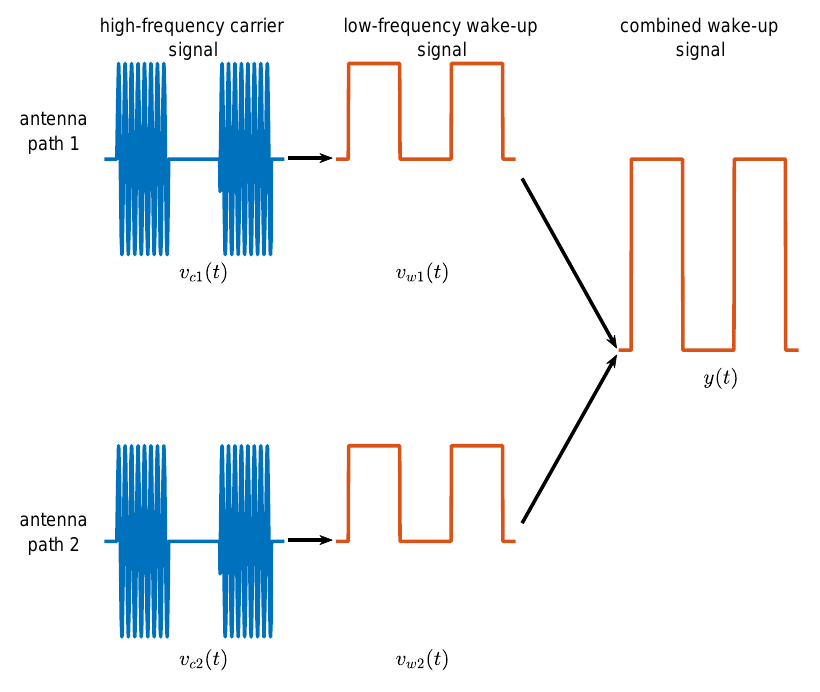
Figure 5. Simplified illustration of the signal chain starting with the on-off-keying modulated high-frequency carrier signals received by the two antennas, the low-frequency wake-up signals after demodulation and the combined wake-up